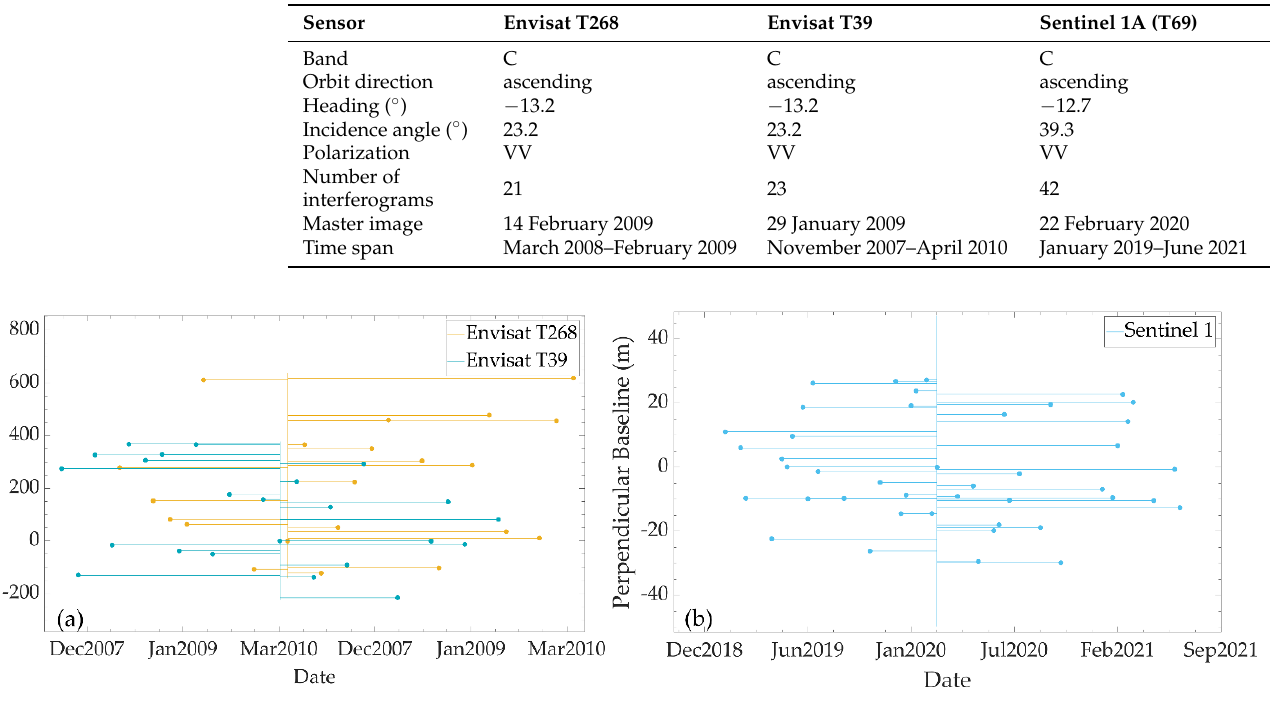
Table 1. Detailed information for the SAR images used in this study.